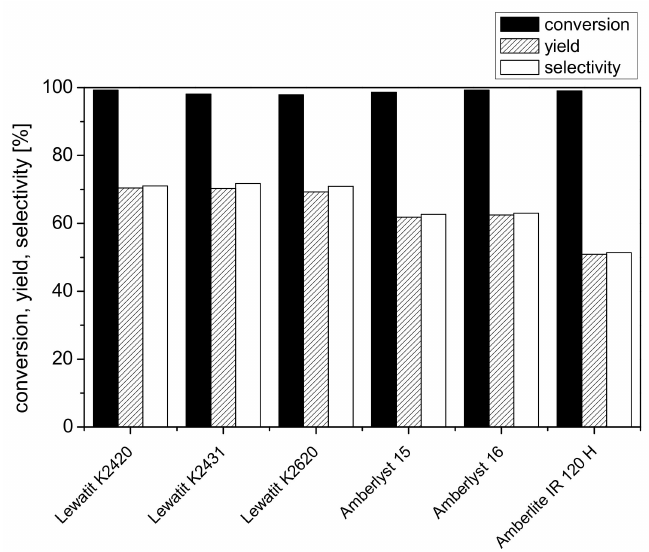
Figure 1. Screening of different ion-exchange resins and their influence on fructose conversion, maximum HMF yield and maximum HMF selectivity. Reaction conditions: 0.5 M fructose, 12.5 vol % water in HFIP, 20 g/L (21.6 mol % (acid sites/substrate)) catalyst and 105 ◦